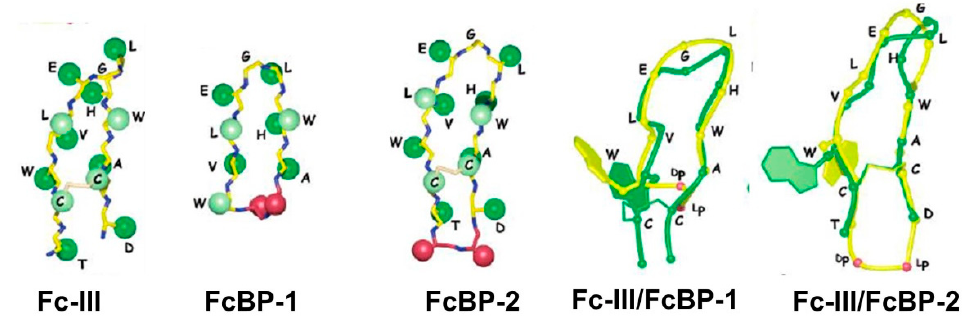
Figure 4. Superimposition of the backbone atoms of the bound structure of Fc-III (green). Adapted from [50], with permission from © 2006 ACS publications. Table 3. Affinities of various ligands that target the Fc-domain of IgG. IC 50 values are from competition BIAcore assays using Protein A with standard deviations from at least three independent experiments. K i values were determined by the method described by DeLano et al. [42]. Adapted from [50], with permission from © 2006 ACS publications.